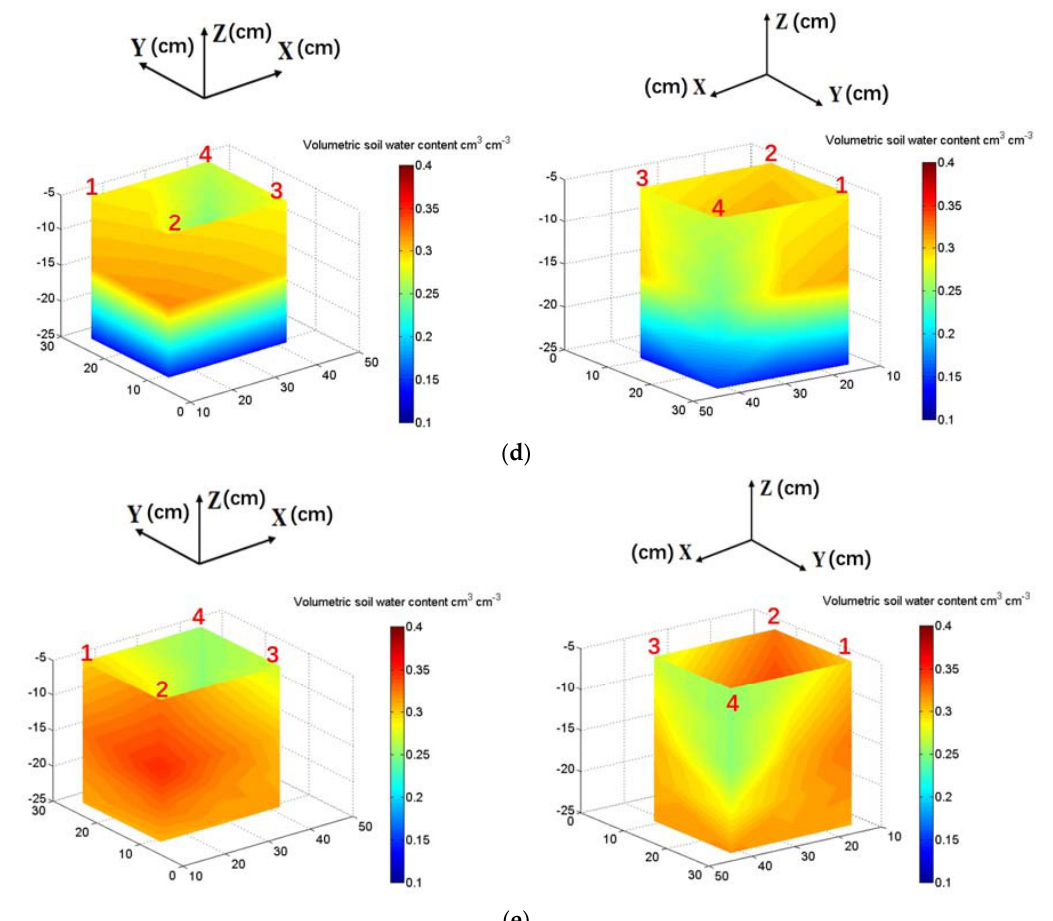
Figure 8. Three-dimensional temporal pattern of VSWC observed by the dielectric tomography system running under single-dripper irrigation condition ( a ) 3D SWC map at starting time (0:00); ( b ) 3D SWC map at 1.5 h (1:30); ( c ) 3D SWC map at 3 h (3:00); ( d ) 3D SWC map at 4.5 h (4:30); ( e ) 3D SWC map at 6 h (6:00).